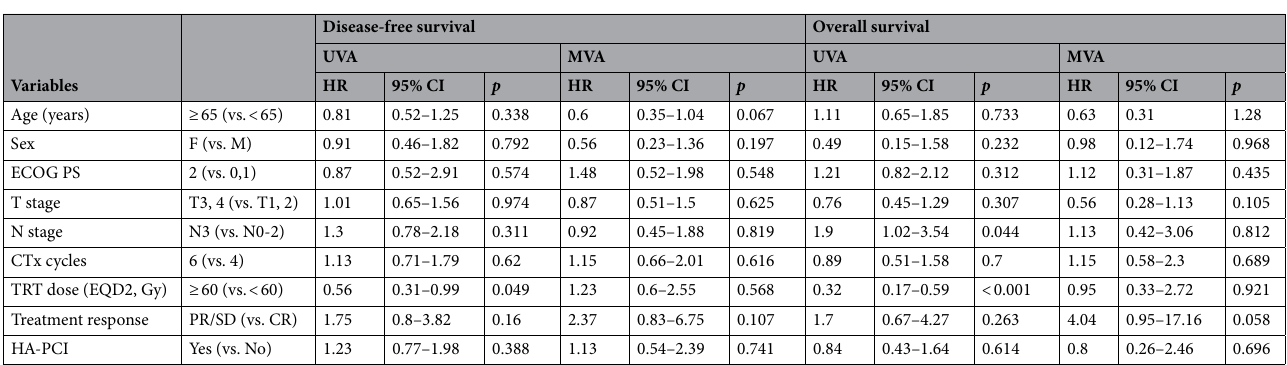
Table 3. Results of the Cox regression analyses for disease-free survival and overall survival. ECOG PS Eastern Cooperative Oncology Group Performance Status, AJCC American Joint Committee on Cancer, CTx chemotherapy, TRT Thoracic radiotherapy, EQD2 Equivalent dose in 2 Gy fractions, α/β = 10, Fx fraction, CR complete response, PR partial response, SD stable disease, HA-PCI hippocampal-avoidance prophylactic cranial irradiation, UVA univariate analysis, MVA multivariate analysis, HR hazard